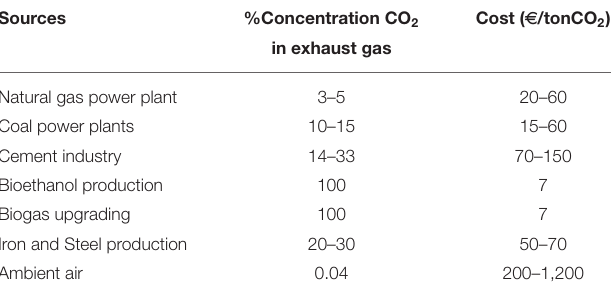
TABLE 4 | CO 2 costs according to different sources and their concentration—based on Gibbins and Chalmers (2008), Ranjan and Herzog (2011), Schiebahn et al. (2015), Atsonios et al. (2016), Bailera et al. (2016), Brynolf et al. (2018), Ghaib and Ben-Fares (2018), and Song et al.